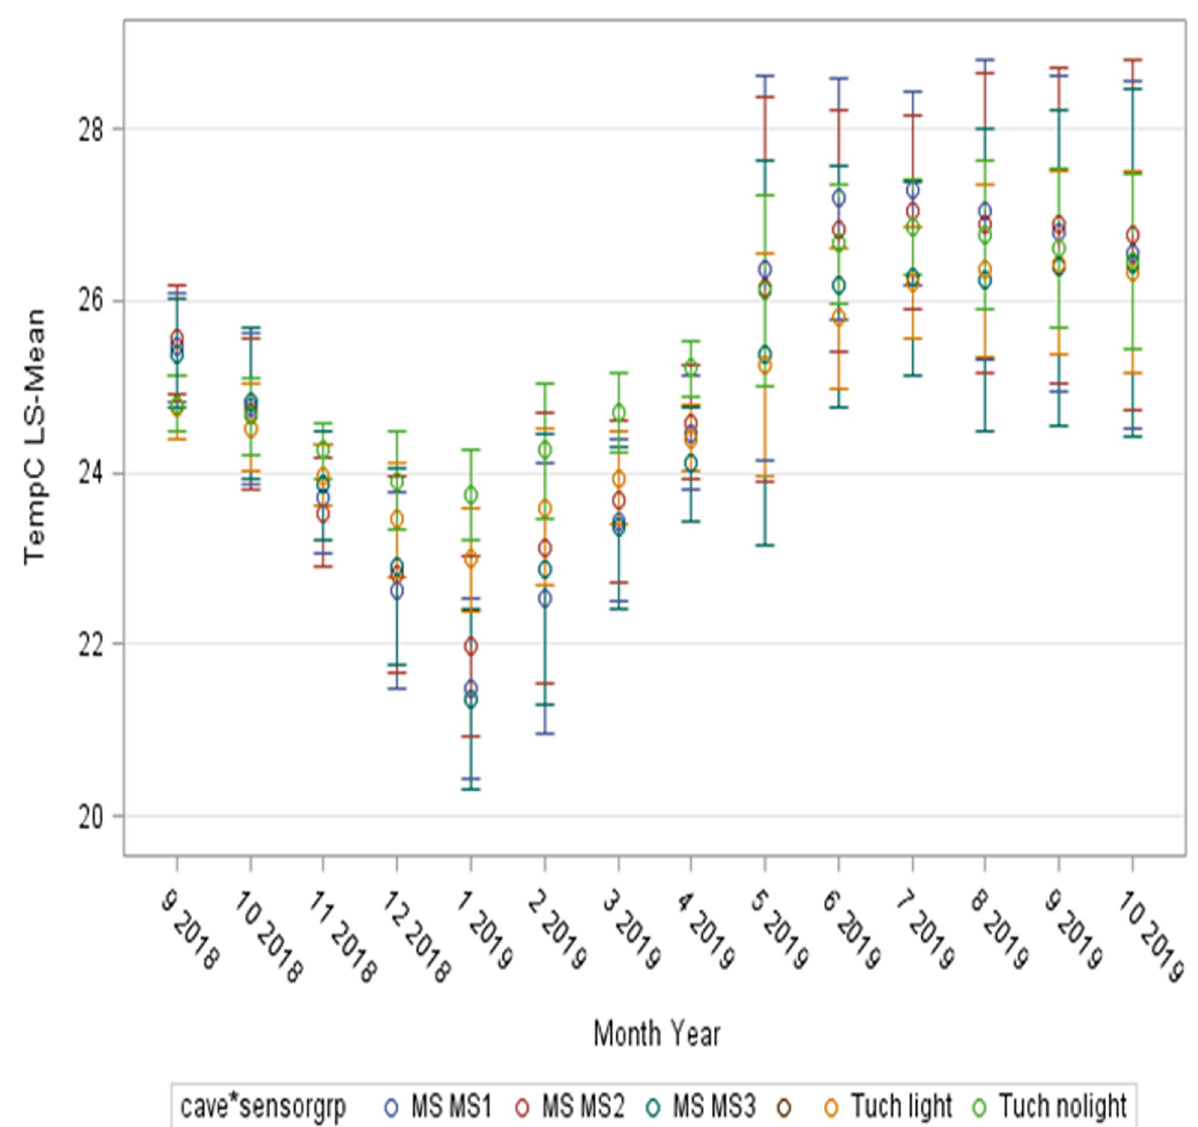
Fig 6. Comparison daily temperatures grouped by month of Rı´o Secreto (labelled as Tuch in figure) and Mue´velo Sabrosito (labelled as MS in figure) based on a generalized linear mixed model (see Table 2). Least Square means are shown as circles and 95% confidence limits are shown as lines. The overall impression is that seasonal differences